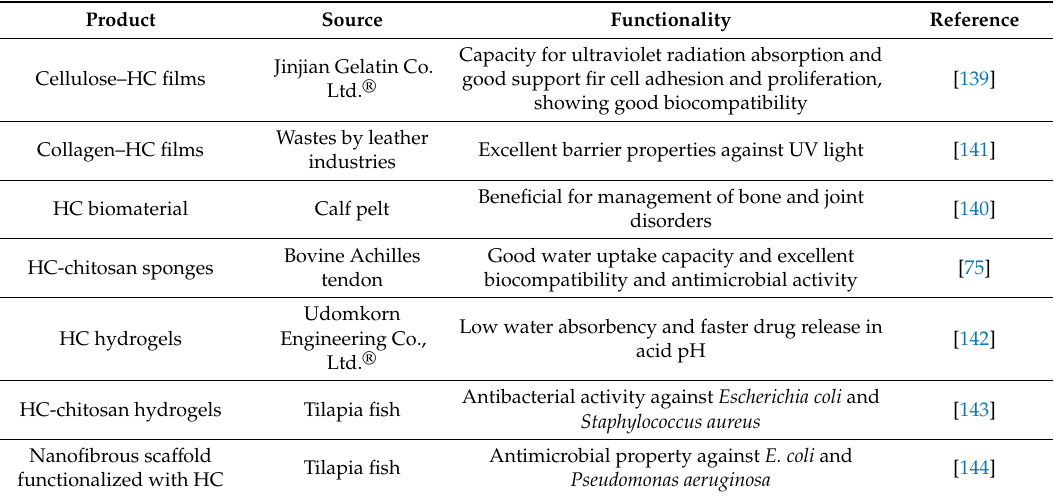
Table 4. Hydrolyzed collagen biomaterial